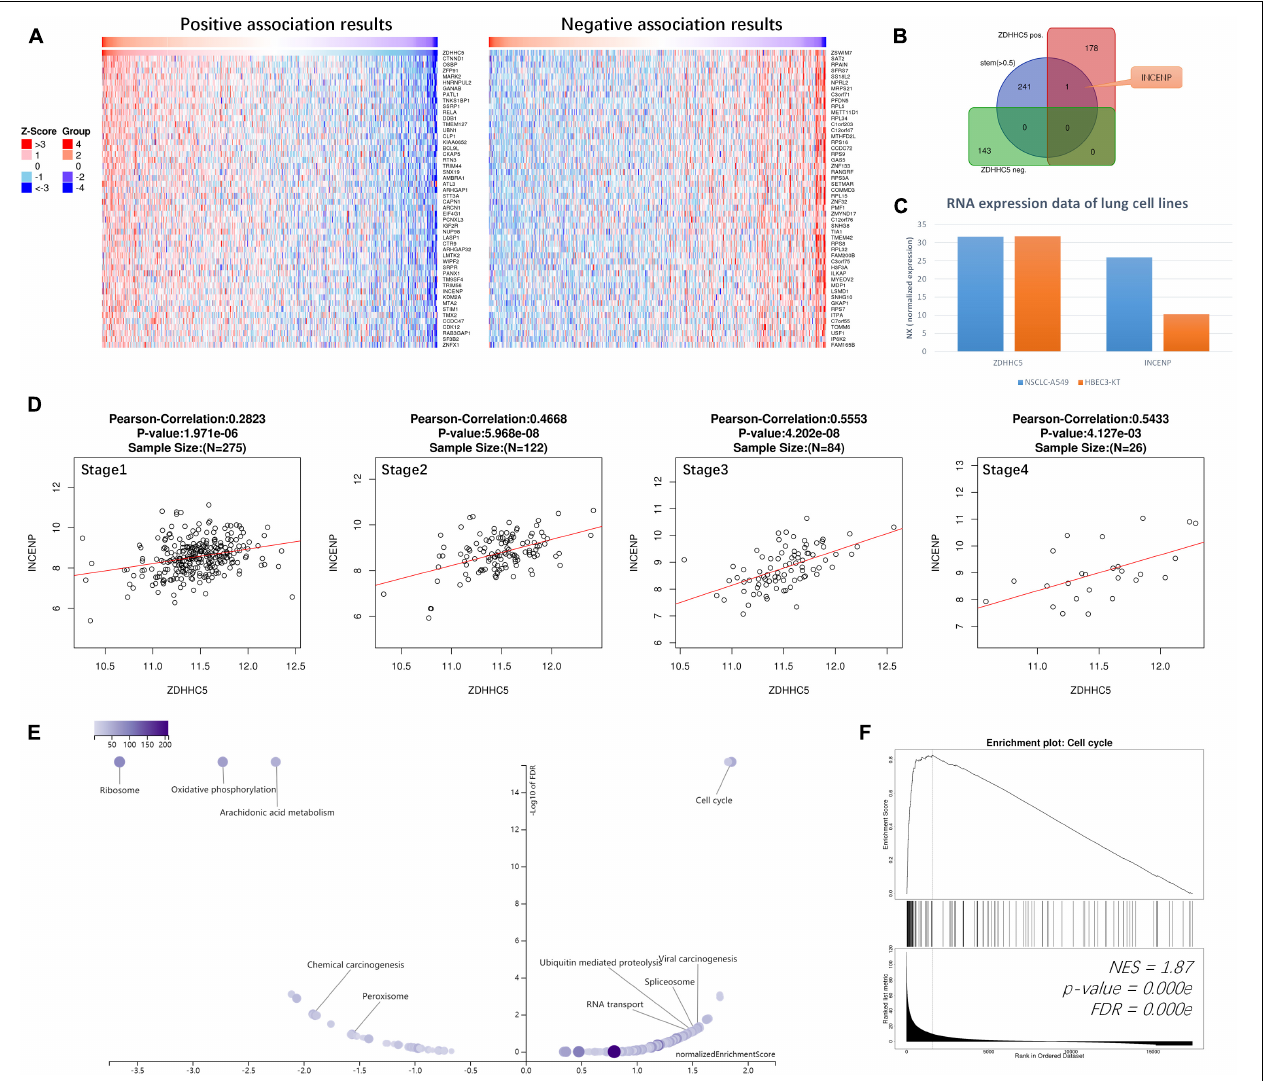
FIGURE 3 | Correlations of ZDHHC5 and INCENP in LUAD. (A) Data for the top 50 positive and negative ZDHHC5 association genes are visualized in heat maps. (B) Venn diagram showing the mapping results of LUAD stemness genes, ZDHHC5 positive and negative expressed genes. (C) The bar plot shows the RNA-seq results of ZDHHC5 and INCENP in A549, HBEC3, and SCLC-21H cell lines from the HPA database. Normalized expression, NX. (D) Correlation analysis of ZDHHC5 and INCENP according to the pathological stages of LUAD cases from TCGA, using Pearson’s correlation tests. (E) The enriched KEGG pathway result clustered by weighted set cover. In the volcano plots, the intensity of color and jitter size indicates the number of the elements in each pathway. (F) GSEA results of cell cycle (hsa04110). NES, normalized enrichment